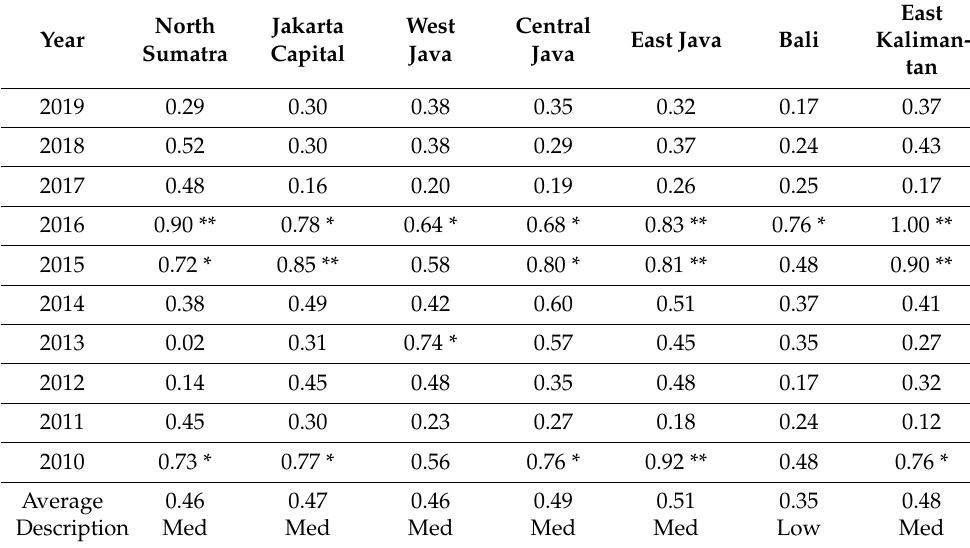
Table 3. Dengue risk assessment for seven provinces in